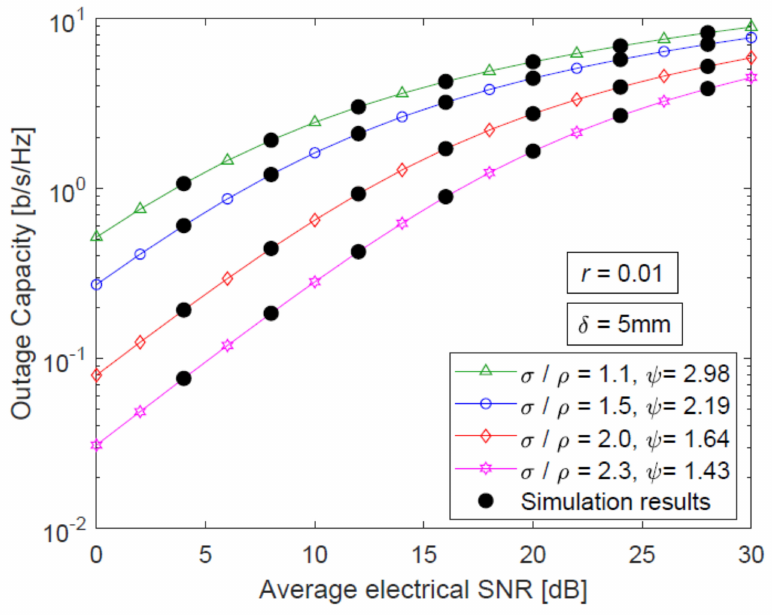
Figure 2. Outage capacity versus average electrical SNR for δ = 5 mm and r = 0.01 under the presence of varying, weak to strong stochastic pointing